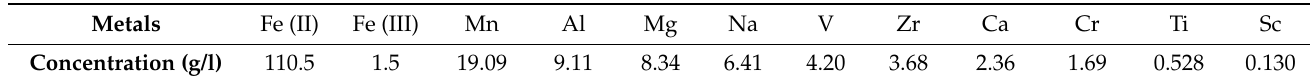
Table 2. Chemical analysis of FeCl 2 feed solution.